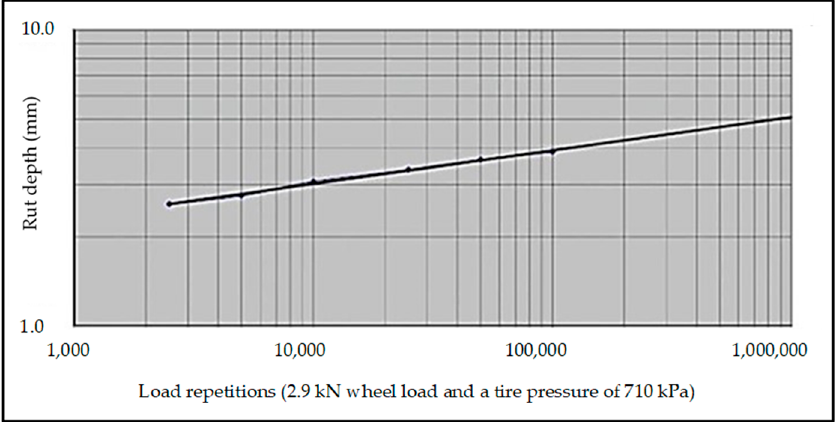
Figure 17. Plot and extrapolation of the average measured rut depth during the 24 h MMLS3 test with 100,000 repetitions done on the Cape seal constructed using unconventional binders.